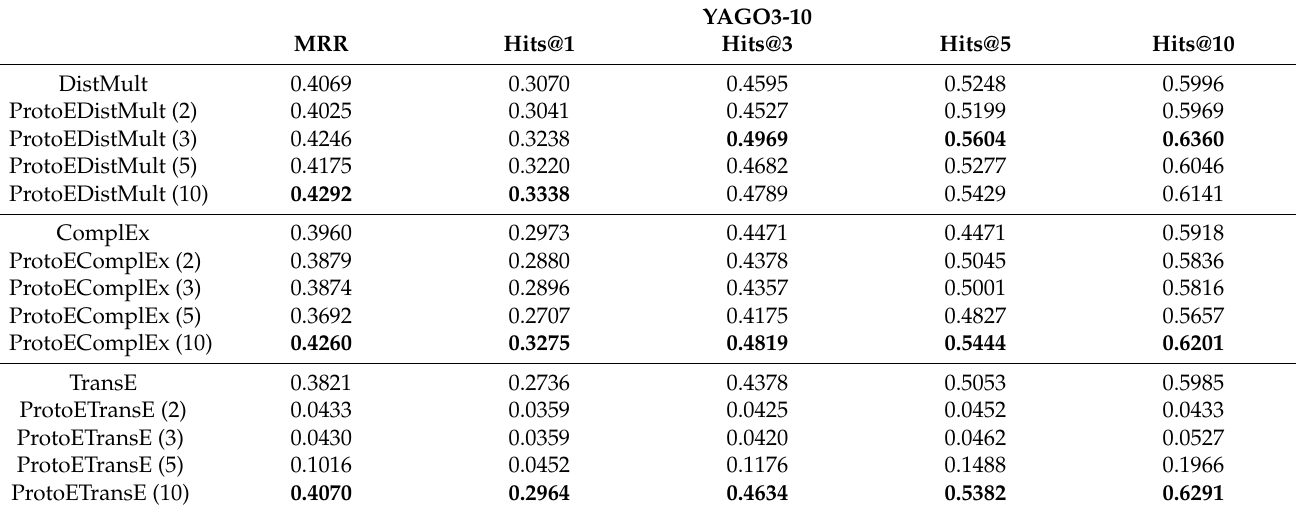
Table 7. Results of ablation experiments for prototype embedding on YAGO3-10. Best values are indicated in